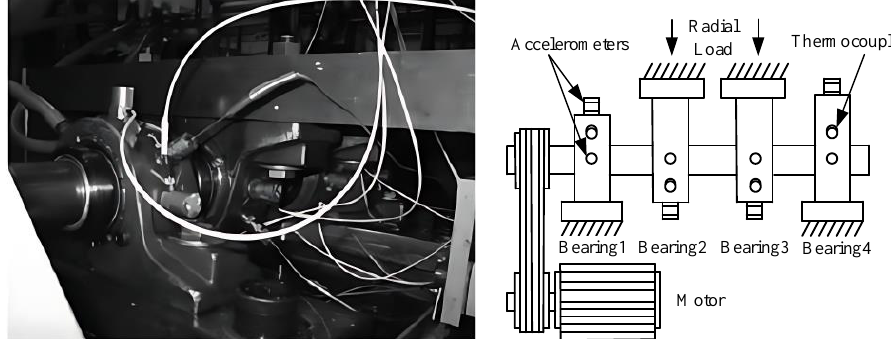
Figure 9. The layout of the bearing accelerated degradation test rig of Case 1.